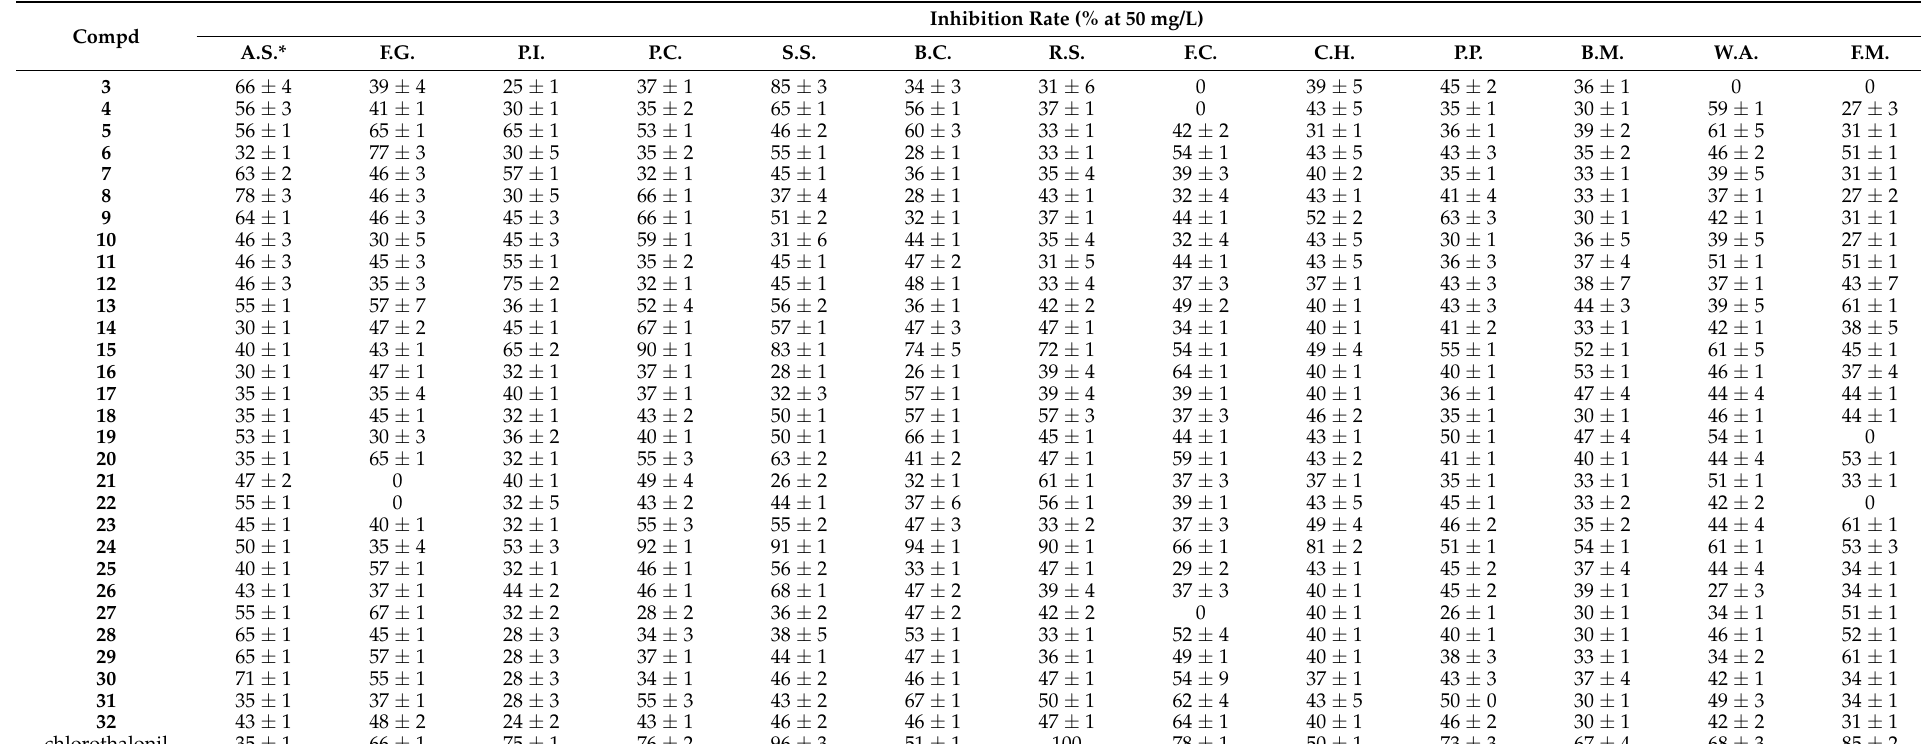
Table 3. Fungicidal activity of compounds 3 – 32 against thirteen kinds of